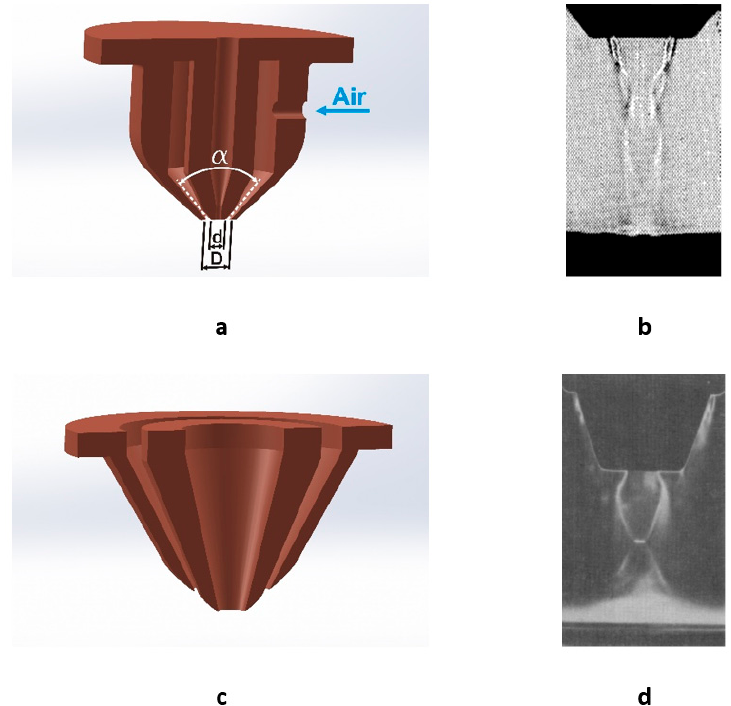
Figure 20. ( a ) Parameters needed to define the nozzle contour in annular nozzles used for laser cutting and ( b ) shadowgraph of the free jet exhausted by an annular nozzle defined by d / D = 0.8, and α = 40° at an assistant pressure of p / p a = 9. ( c ) Coanda nozzle, and ( d ) Schlieren image of an impinging jet ejected by this kind of nozzle. Reprinted with permission from [97,102]; Copyright 1990 The Japan Society of Mechanical Engineers, 1992 SPIE.